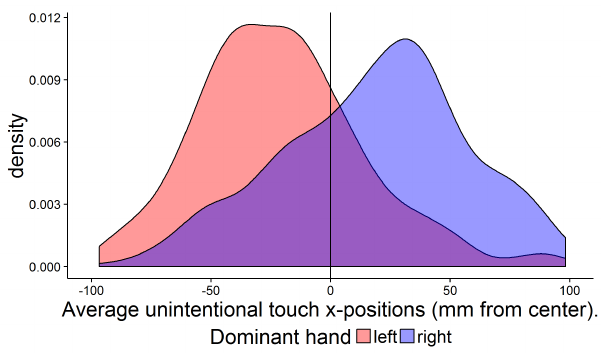
Figure 11. Distribution density of unintentional touch x-position session averages from Figure